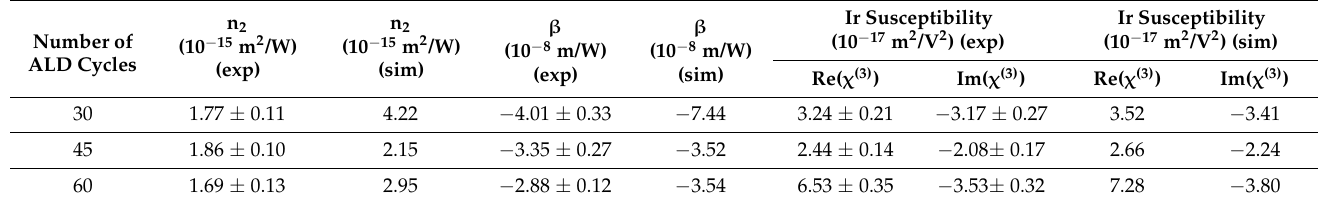
Table 2. Experimental (exp) and simulated (sim; with fitted third-order susceptibility at 700 nm wavelength) values of nonlinear refractive index n 2 , nonlinear absorption coefficient ß , and third-order susceptibility χ (3) of selected Ir NP samples at the 700 nm fundamental